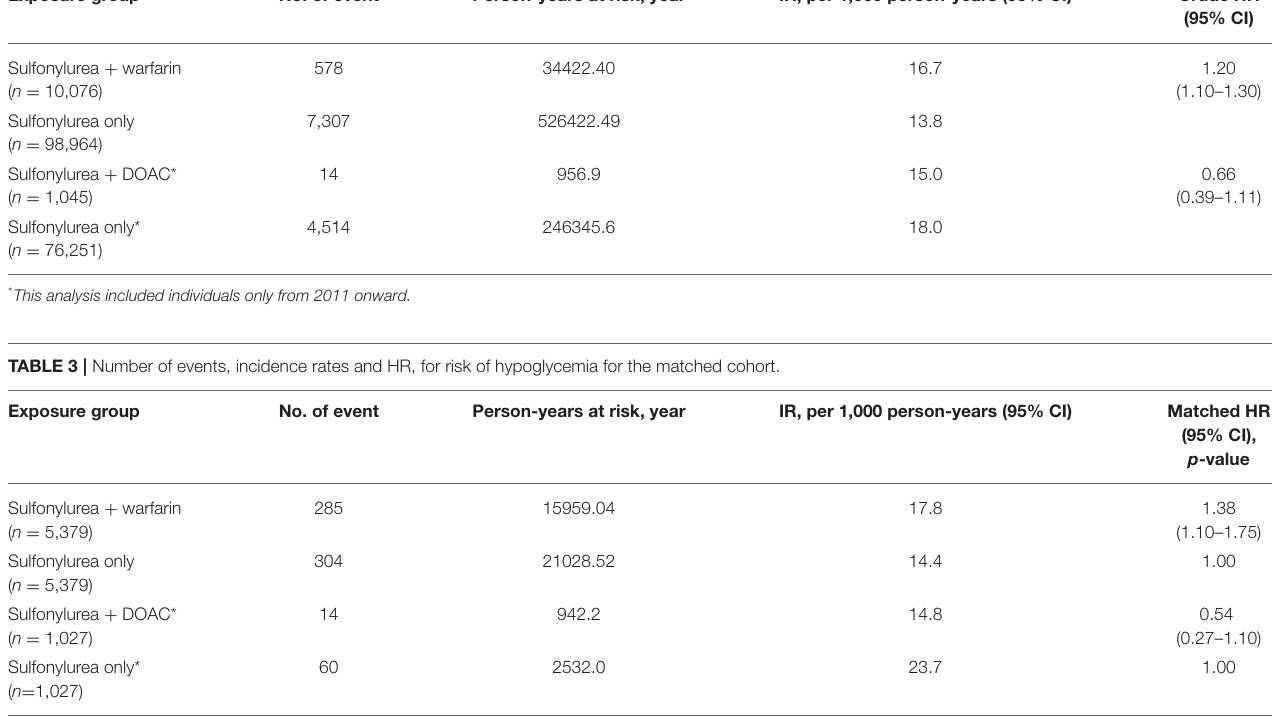
TABLE 2 | Number of events, incidence rates and crude HR, for risk of hypoglycemia. Exposure group